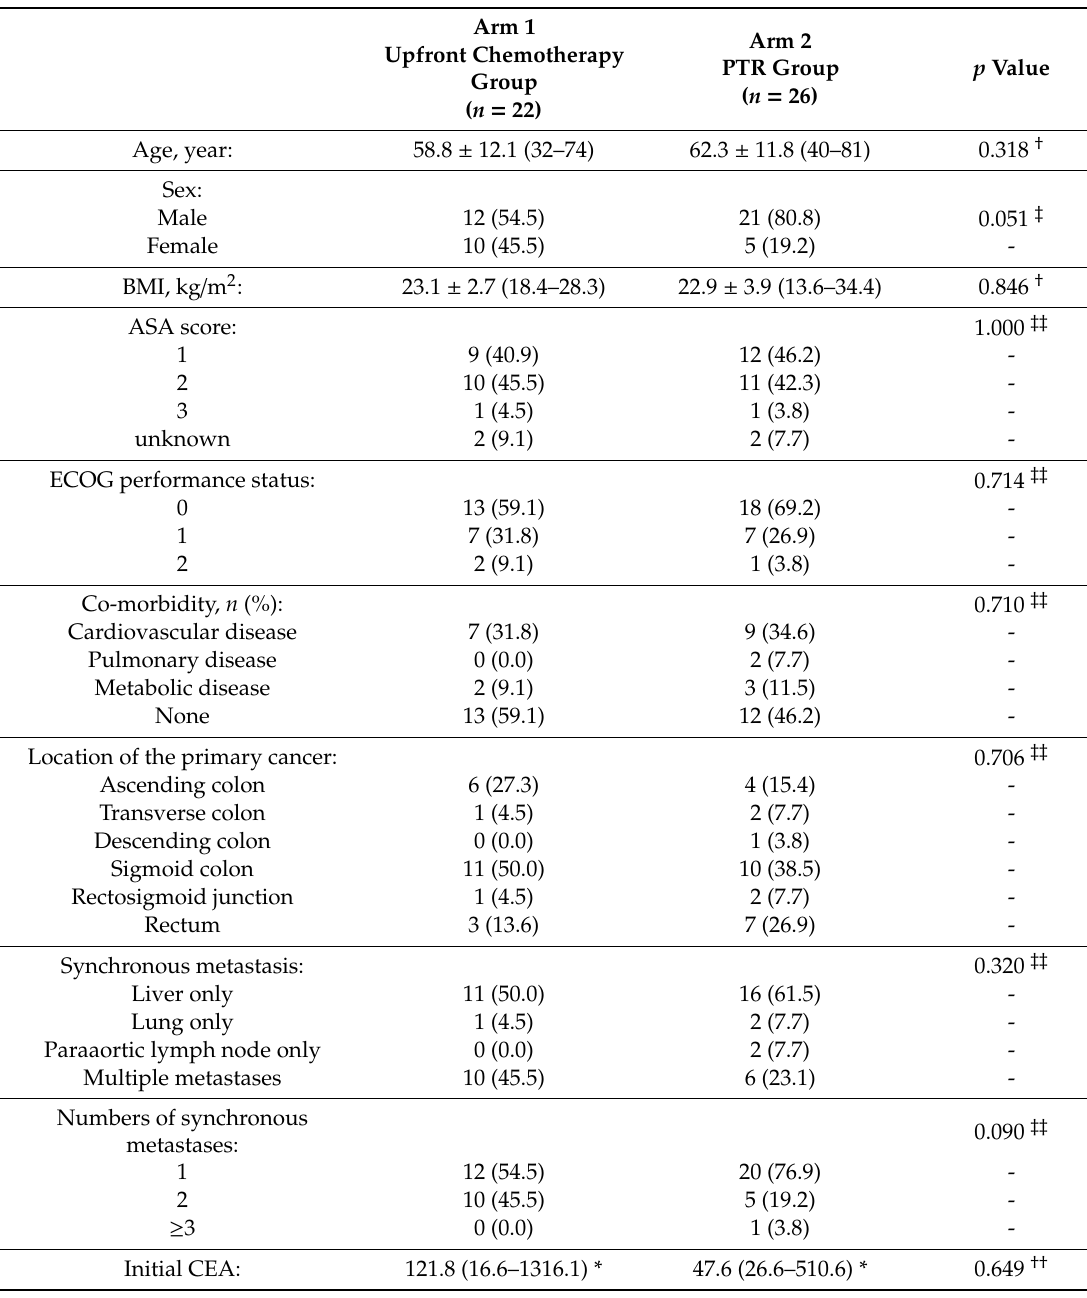
Table 1. Baseline patient